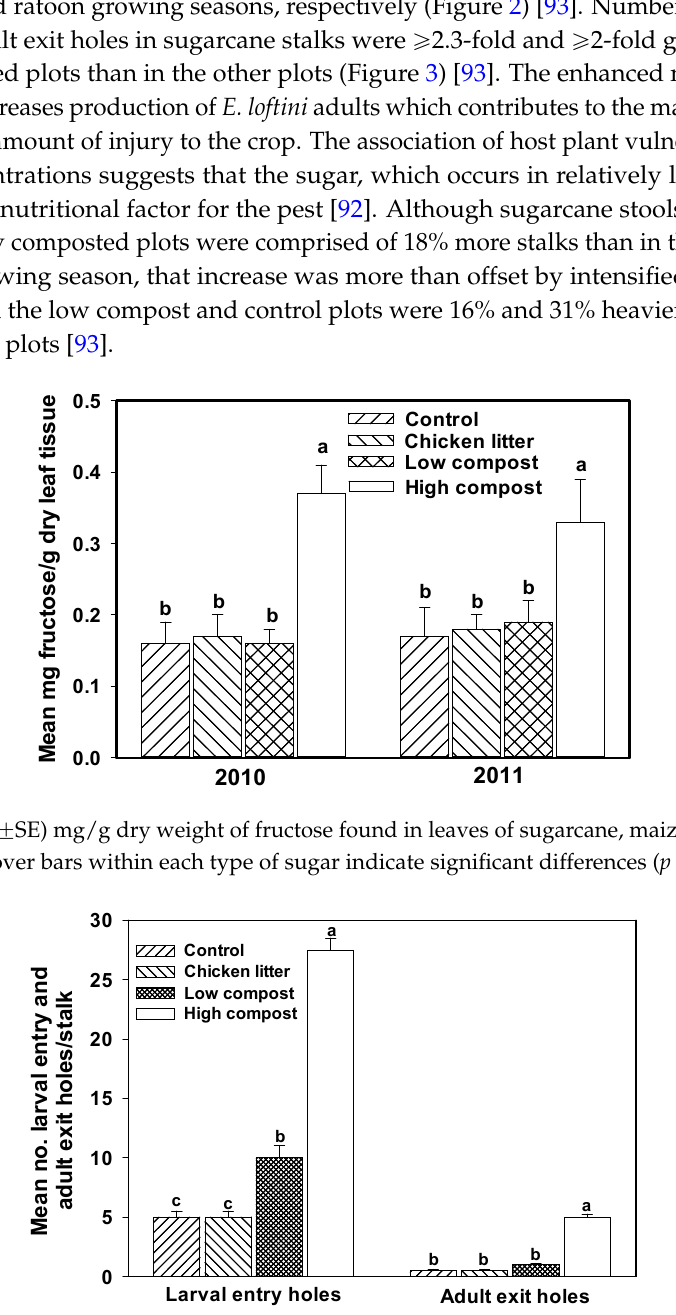
Figure 3. Mean (±SE) numbers of E. loftini larval entry holes and adult exit holes in sugarcane stalks grown on field plots amended with chicken litter, or low (102,306 kg/ha) and high (306,916 kg/ha) amounts of compost, and in non-amended control plots, 2011, Hidalgo Co., TX; letters over bars for each type of hole indicate significant differences ( p < 0.05) [93].